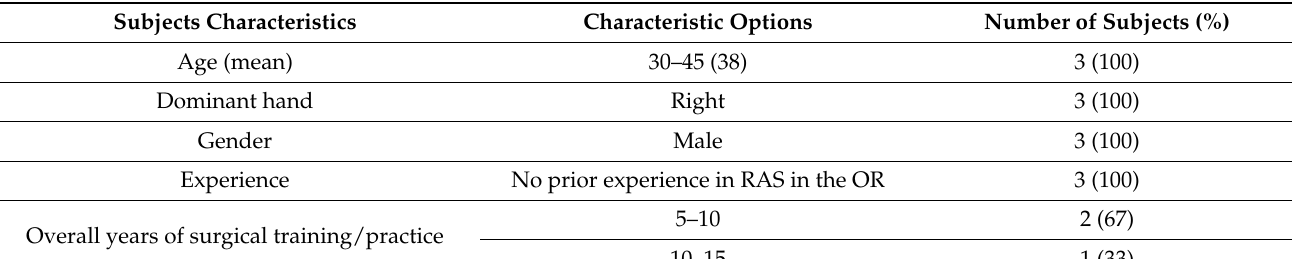
Table 1. Demographics. RAS: Robot-assisted surgery; OR: operating